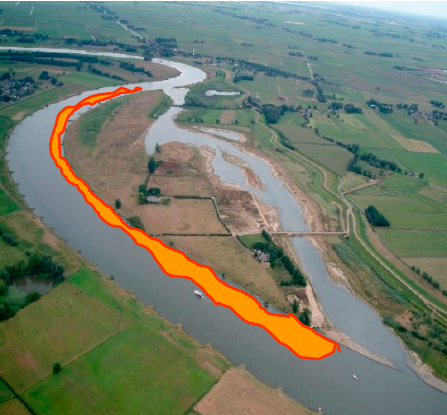
Figure 23. Possible aggradation through secondary channel Westenholte (yellow marking) (copyright RWS).